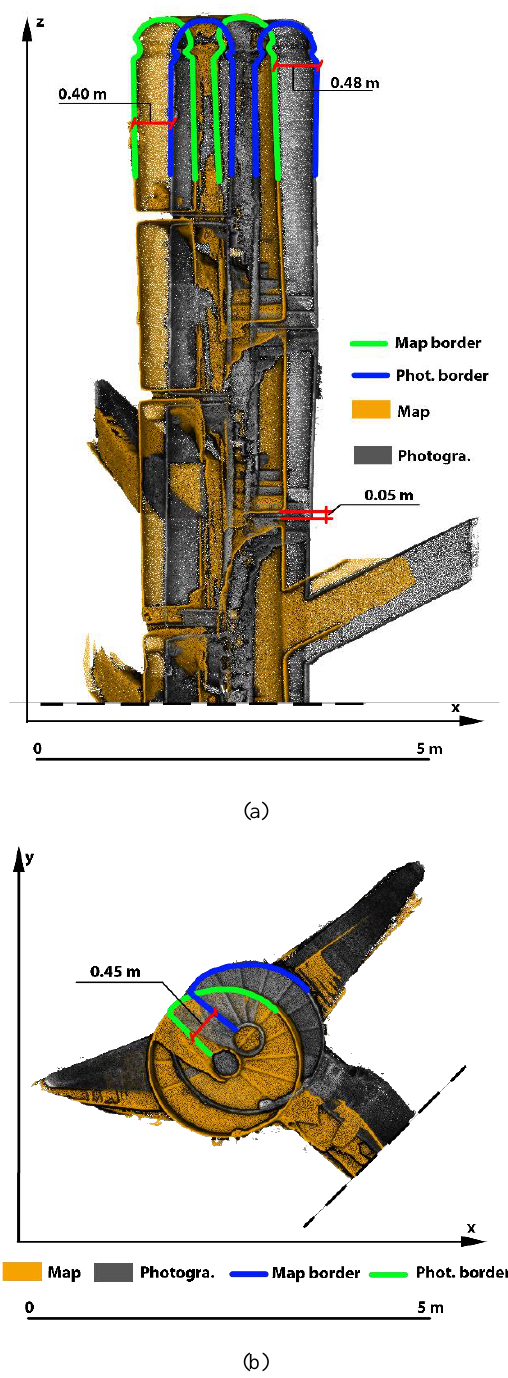
Figure 7. Spatial map ground truth deviations (a) on xy plane. and (b) on the xz